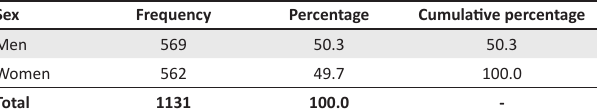
TABLE 1: Respondent sex.